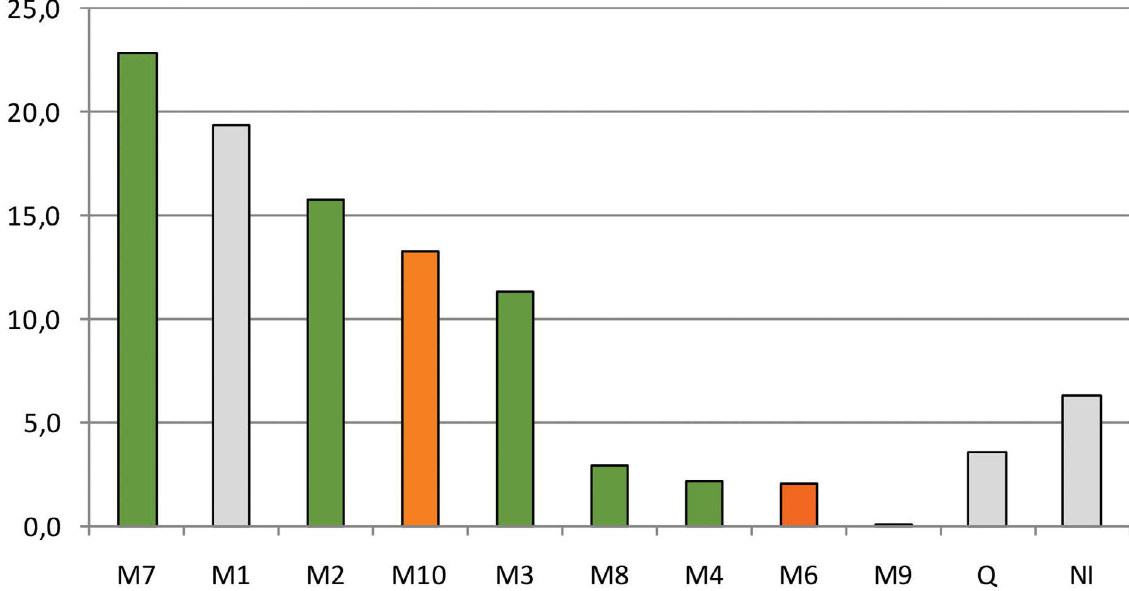
Figura 12. Tipos de microfácies das pontas de seta do Zambujal (%): as barras verdes representam as microfácies consideradas de proveniência cretácica; as barras cor de laranja representam as microfácies consideradas de proveniência paleogénica e as barras cinzentas representam as microfácies cuja proveniência não foi possível identificar. Figure 12. Zambujal arrow points microfacies types (%): green bars represent microfacies considered as cretaceous origin; the orange bars represent microfacies considerate as palaeogeneous origins; and the grey bars represent unidentified microfacies